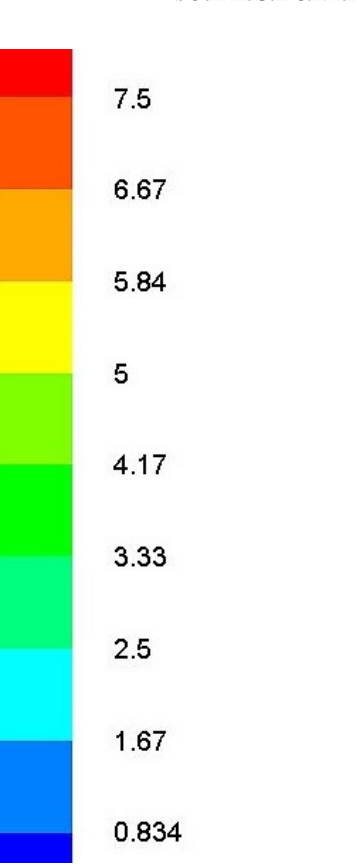
Figure 5. Evaluation of airflow (cm 3 /s) in frontal sections 2–7 in the nasal cavity. Distribution of airflow is color-coded: blue—the lowest; red—the highest.